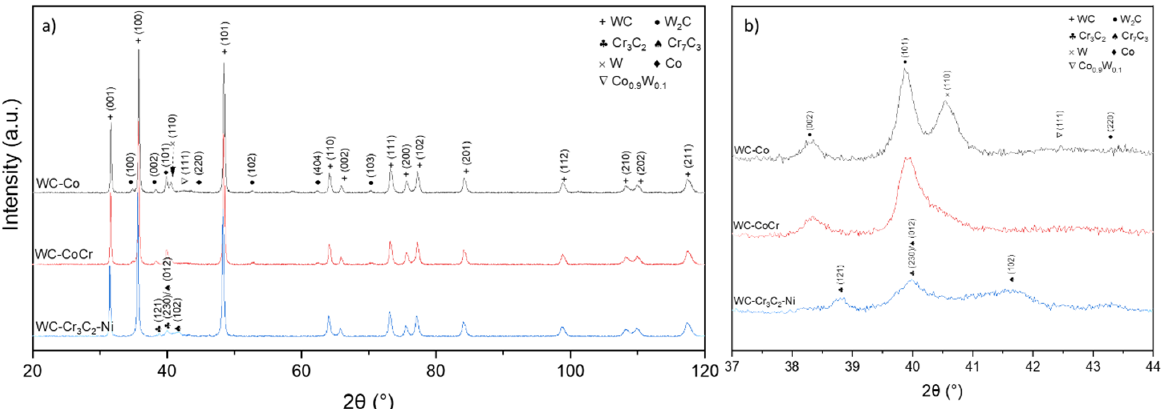
Figure 15. Typical XRD patterns obtained from cermet coatings sprayed onto magnesium substrate: ( a ) whole pattern, ( b ) magnification of chromium carbides region.